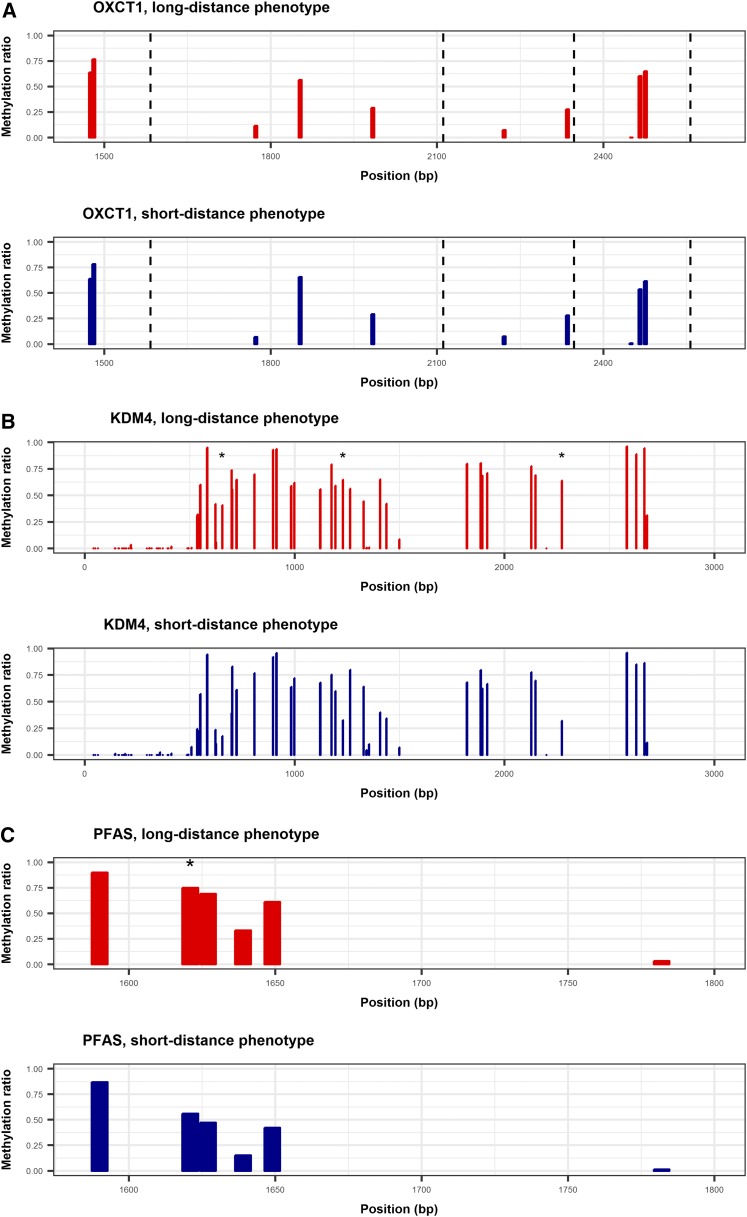
Methylation of selected loci in three genes as detected using targeted bisulfite sequencing. The bar graphs present the average methylation ratio at each CpG site detected for (A) succinyl-CoA:3-ketoacid coenzyme A transferase 1 (OXCT), (B) lysine-specific histone demethylase (KDM4), and (C) phosphoribosylformylglycinamidine synthase (PFAS). Methylation ratios were calculated as the average for each flight phenotype. The three CpG sites in KDM4 and one site in PFAS that were significantly hypermethylated (P < 0.05) in long-distance flying insects are shown with * in the top panel. Dashed lines represent exon–exon boundaries for OXCT.